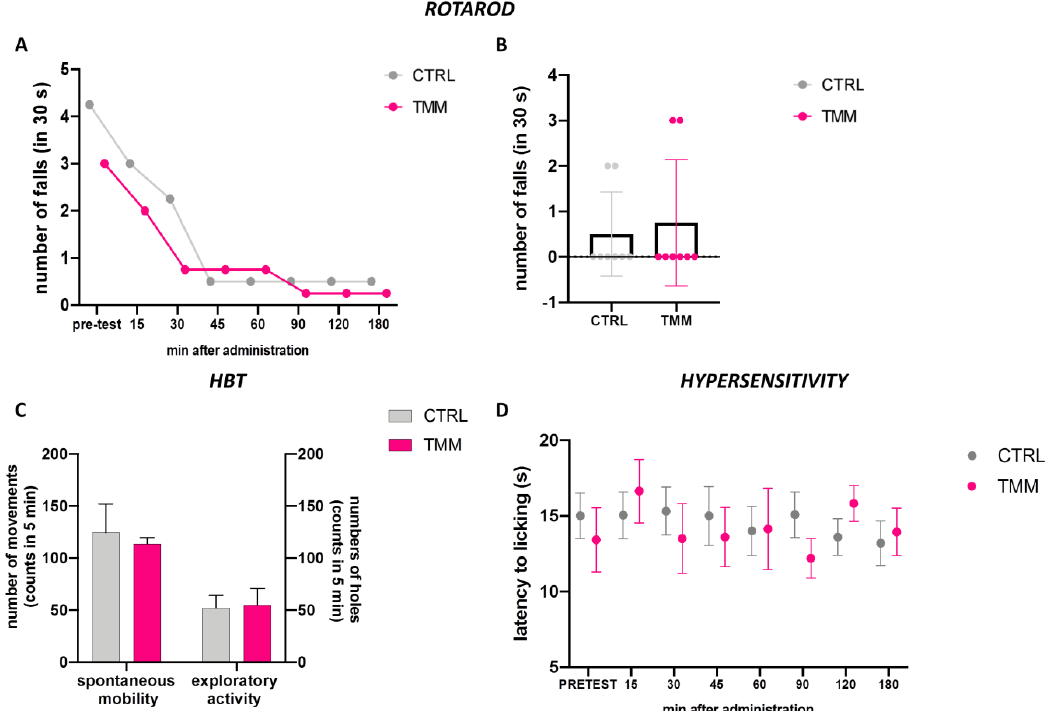
Figure 4. Lack of impairment of motor coordination observed with the rotarod test: 3 h time course ( A ) and 60 min after p.o. ( B ). Spontaneous mobility and exploratory activity measured by the hole board test 60 min after p.o. ( C ). Evaluation of the hypersensitivity by hot plate test from 0 to 180 min after p.o. ( D ).